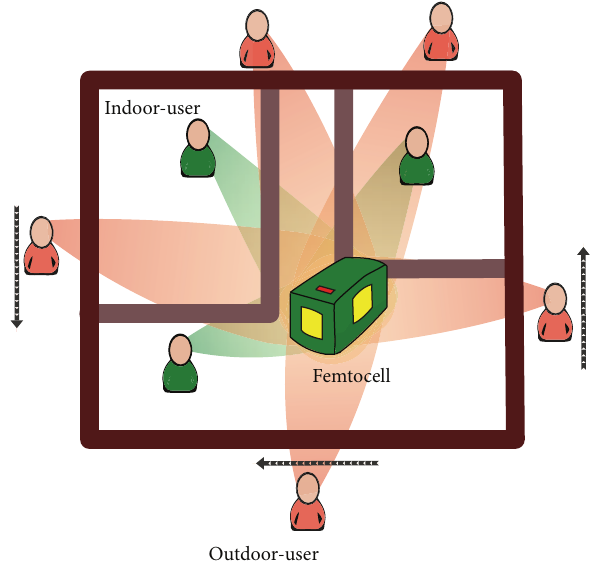
Figure 1: User pattern in closed access femtocell network.